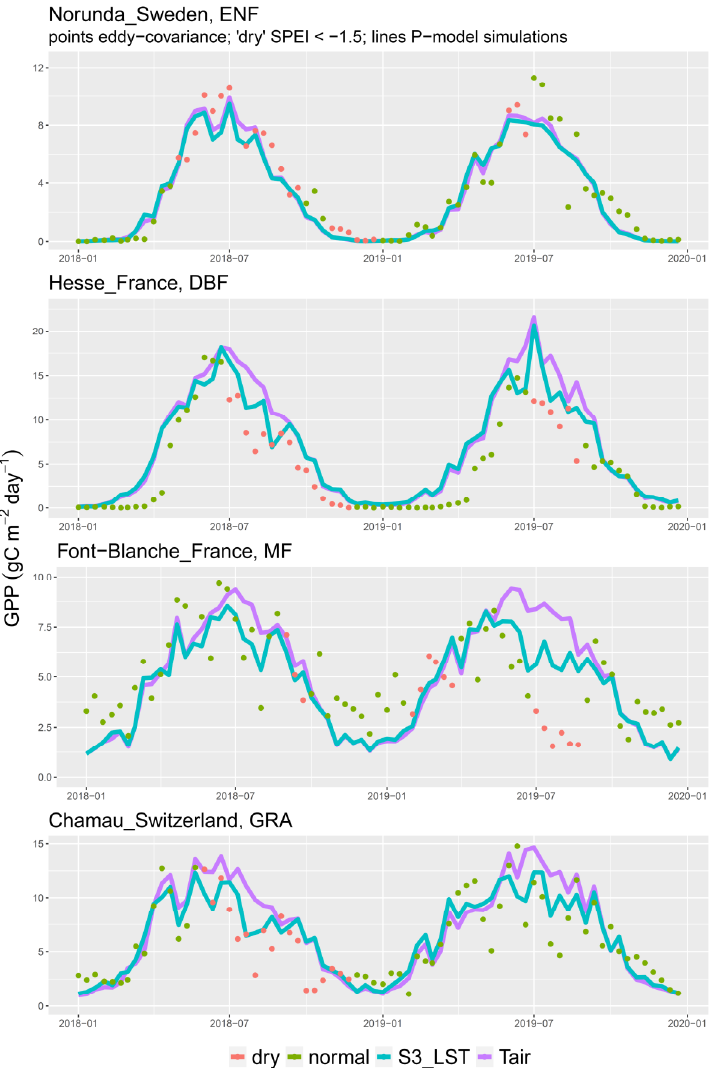
Figure 4. Seasonal variation in GPP estimates for selected sites. Inferred (eddy-covariance) values are shown as points: those periods with a site-specific SPEI < −1.5 are indicated in red. GPP simulations are shown as lines: forced with ECMWF gridded air temperature (purple) and forced with Sentinel3 daytime LST (cyan). Notice that the ranges on the y-axes vary between the plots.